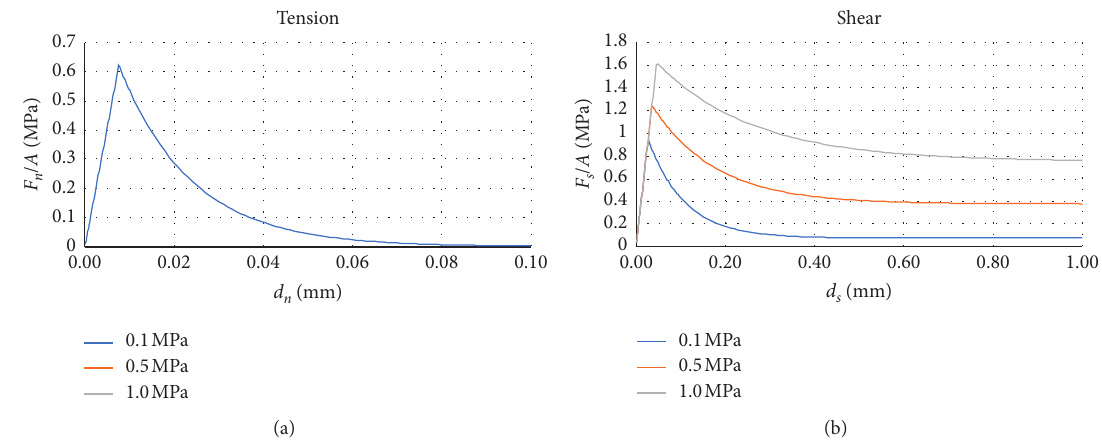
Figure 3: Load-relative displacement curves for a) tension test, b) shear tests with three levels of compression, on two blocks connected by a mortar joint.